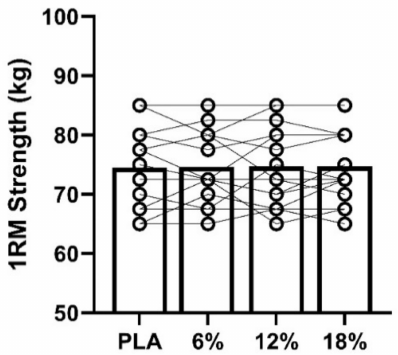
Figure 2. 1-RM strength (kg) across the four